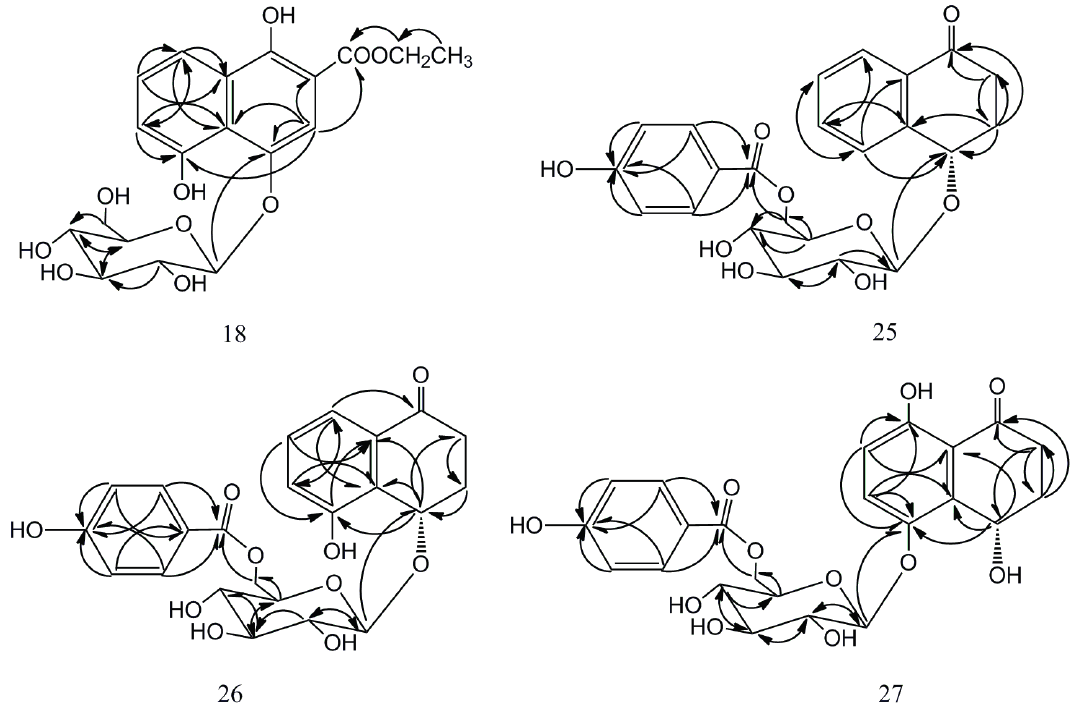
Figure 2. Key HMBC correlations of compounds 18 , 25 – 27